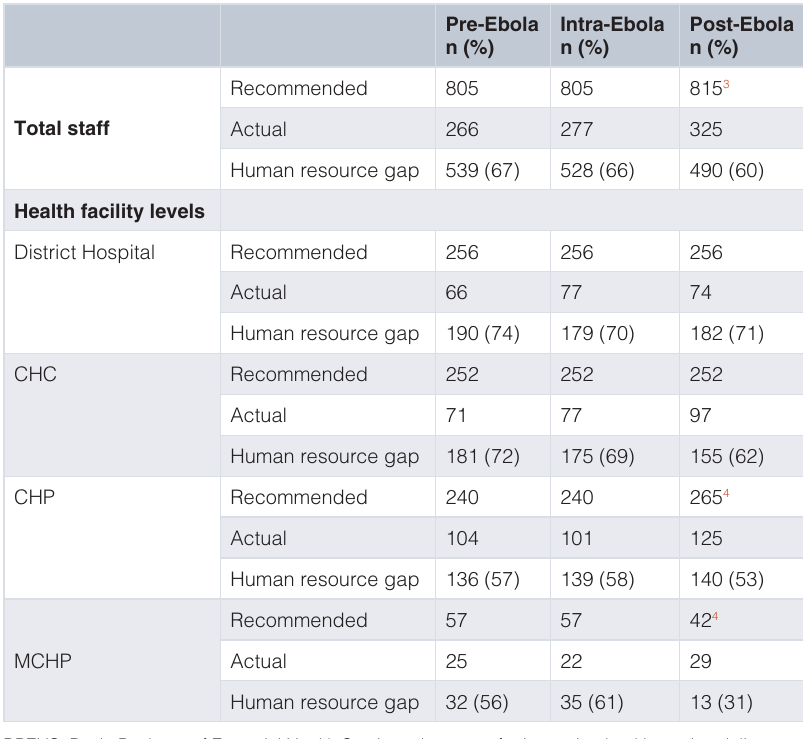
Table 1. Overall medical staffing 1 levels and gaps in relation to the recommended BPEHS standards assessed pre-, intra- and post-Ebola 2 in Kailahun district, Sierra